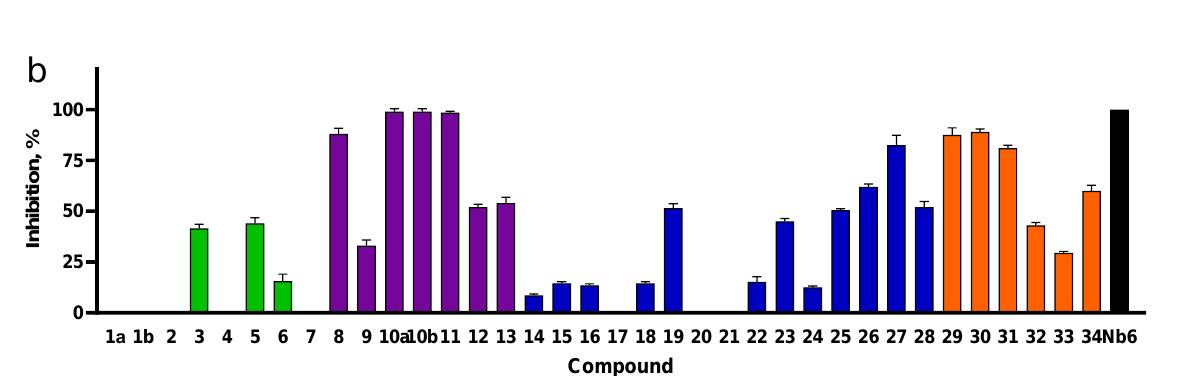
we used. Thus, initial testing in the RBD–ACE2 system revealed moderate activity only in